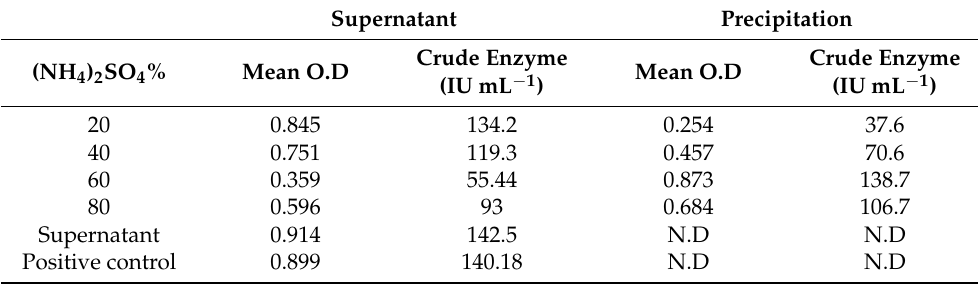
Table 3. Enzyme concentration in supernatant and precipitate after adding (NH 4 ) 2 SO 4 .